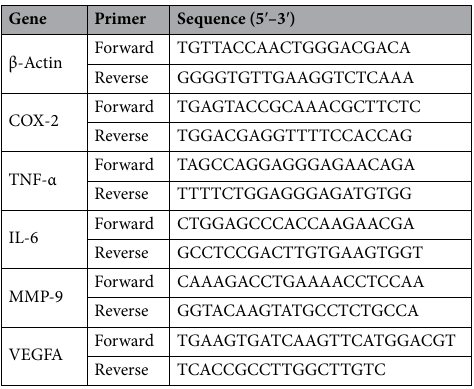
Table 4. Primers used for the quantitative real-time